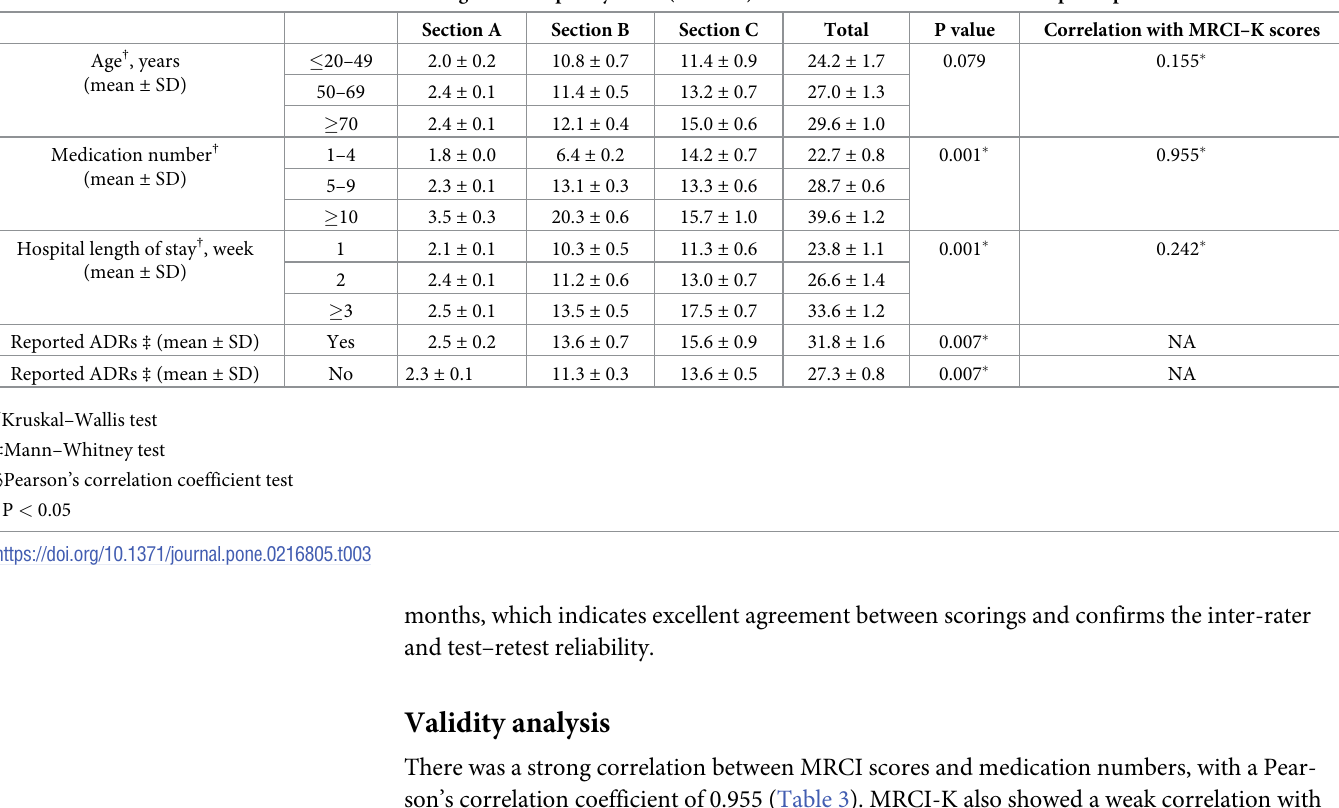
Table 3. Correlation between the Korean Medication Regimen Complexity Index (MRCI-K) scores and characteristics of the 331 participants.